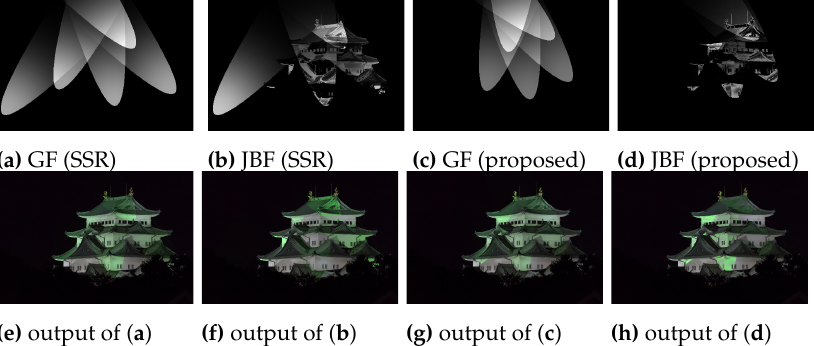
Figure 14. Directional diffusing with 5 points selected: ( a , b , e , f ) from SSR, ( c , d , g , h ) from the proposed.